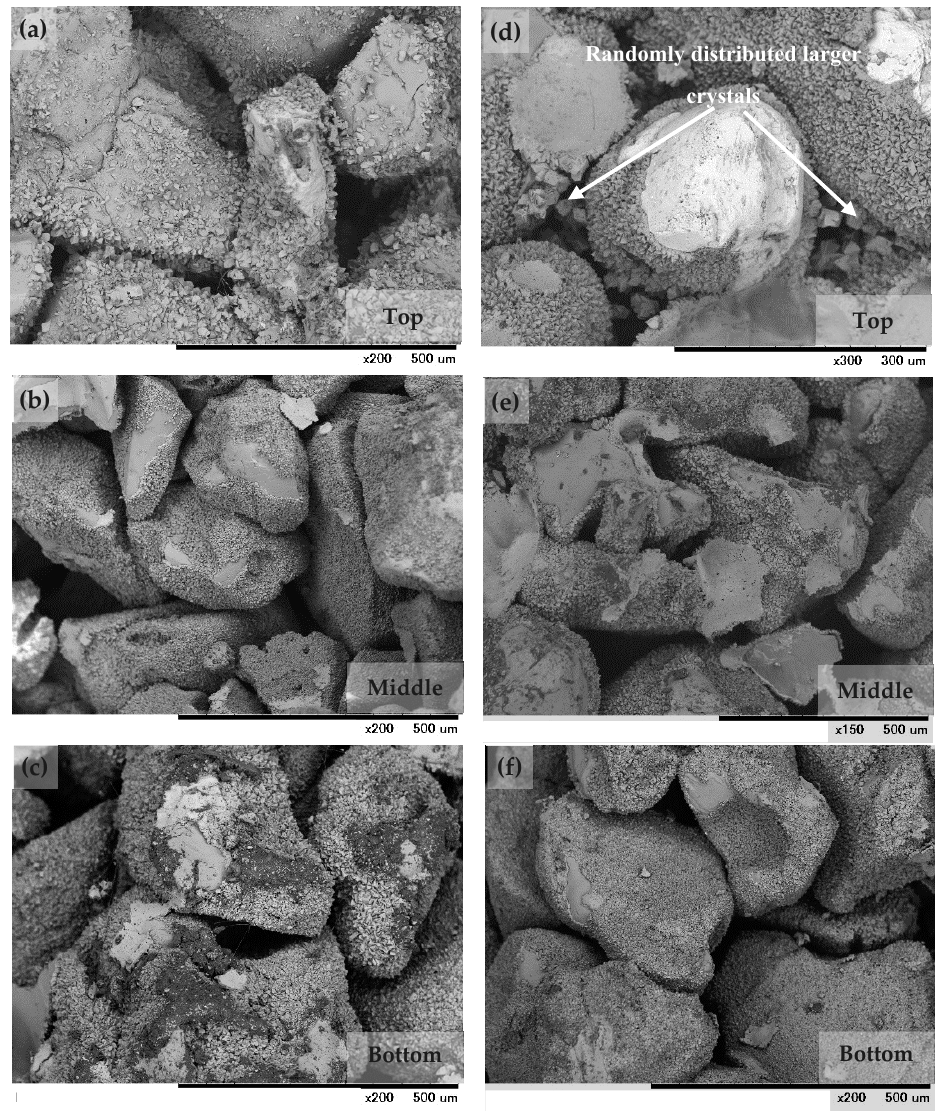
Figure 9. SEM images of showing variation of crystal morphology for the samples treated under different bacteria and reactant concentrations: ( a – c ) 0.5 M cementation solution with bacteria injected twice; ( d – f ) 1.0 M cementation solution with bacteria injected only in the beginning.